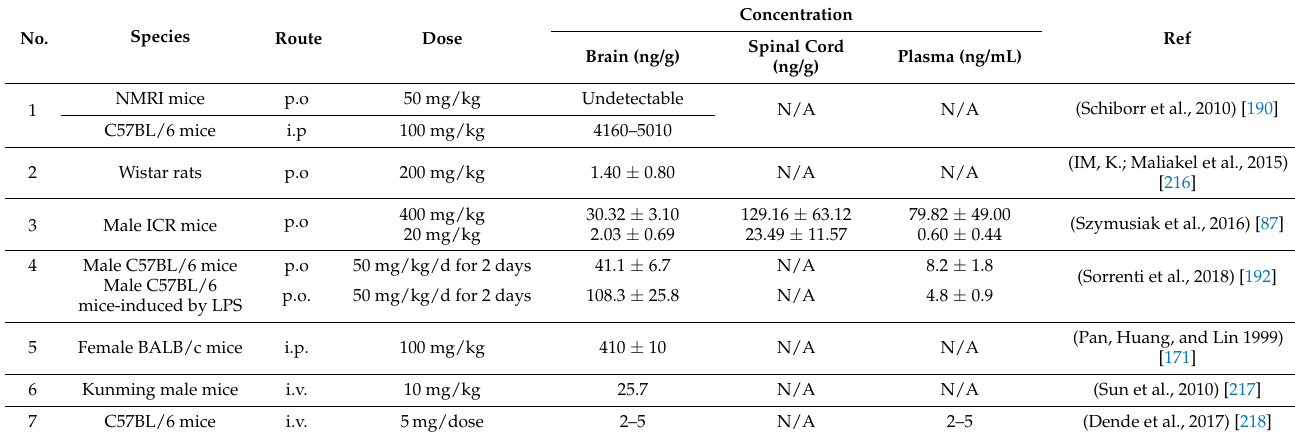
Table 6. Brain pharmacokinetic of